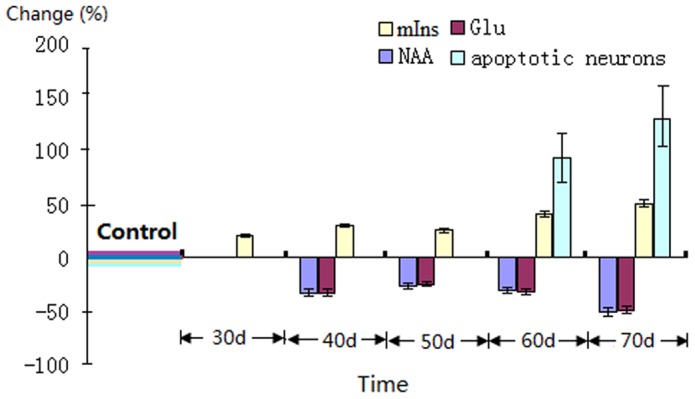
Significant changes of mIns, NAA, Glu and apoptotic neurons in senescent mice at different time point.Data (mean ± SD) are expressed as a % relative to the average control level. Changes in mIns (started on day 30), NAA and Glu (started on day 40) preceded brain neuronal degeneration (started on day 60).